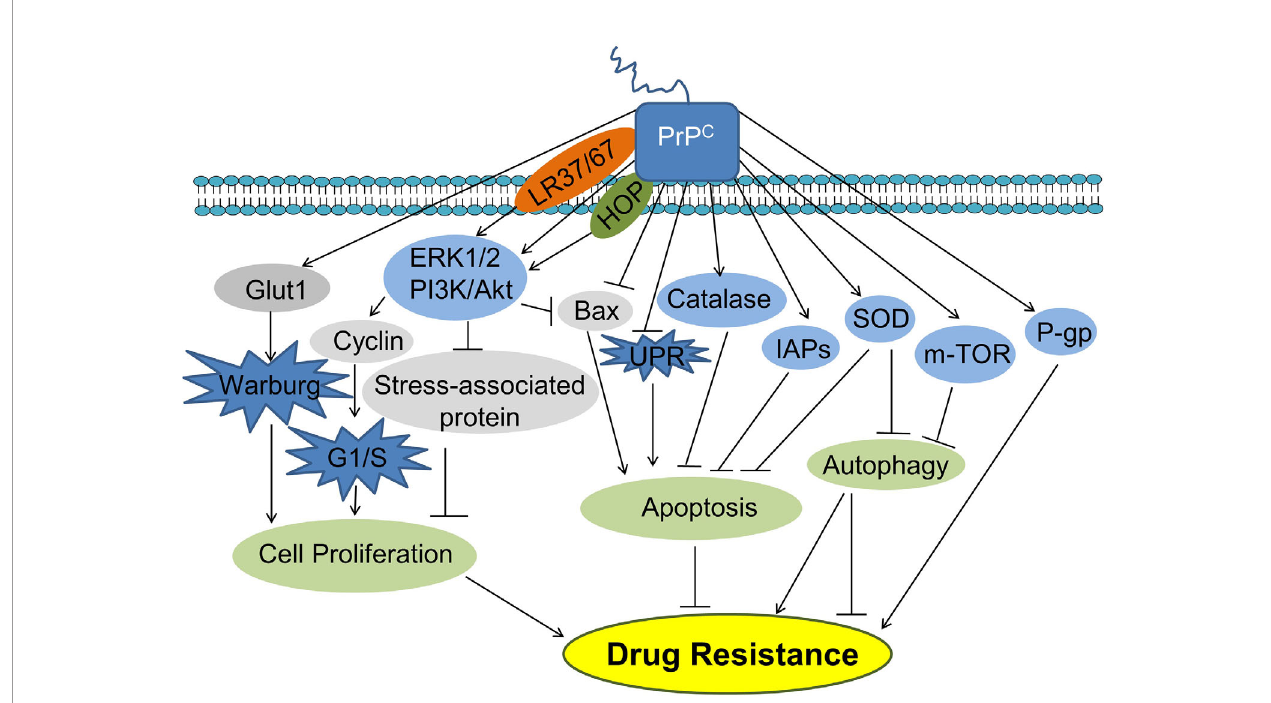
FIGURE 3 | PrP C promotes cancer cell drug resistance. PrP C can promote cancer cell drug resistance by promoting cell proliferation and inhibiting apoptosis. PrP C can also suppress autophagy inhibiting or promoting drug resistance. HOP, Hsp70/90 organizing protein; IAPs, Inhibitors of apoptosis proteins; Glut1, Glucose transporter 1; PI3K, Phosphatidylinositide 3-kinase; AKT, Protein kinase B; Bax, Bcl-2-associated X protein; UPR, Unfolded protein response; SOD, Superoxide dismutase; P-gp,